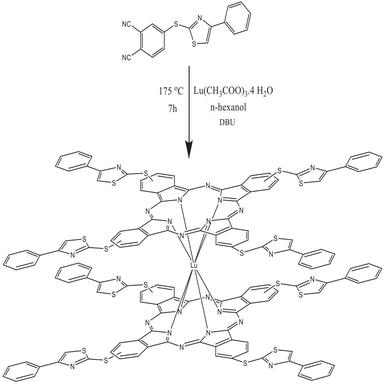
Synthesis of the novel lutetium(III) bisphthalocyanine.